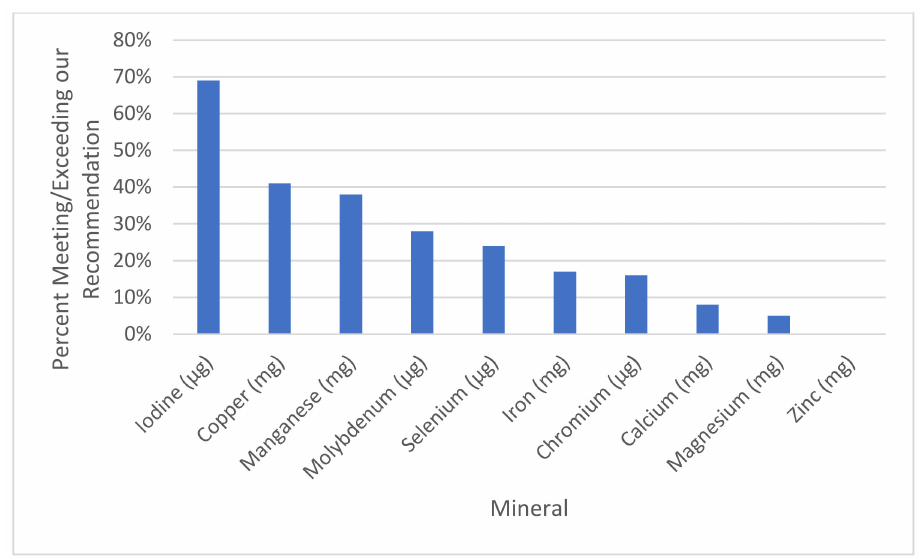
Figure 2. Percent of supplements meeting or exceeding our